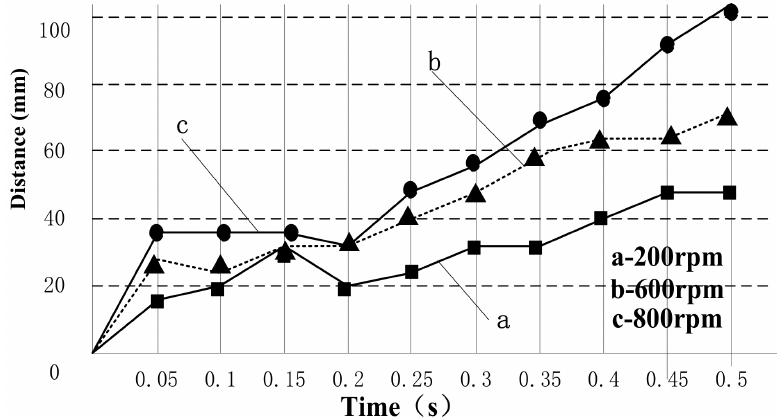
Figure 12. Particles speed with different rotary